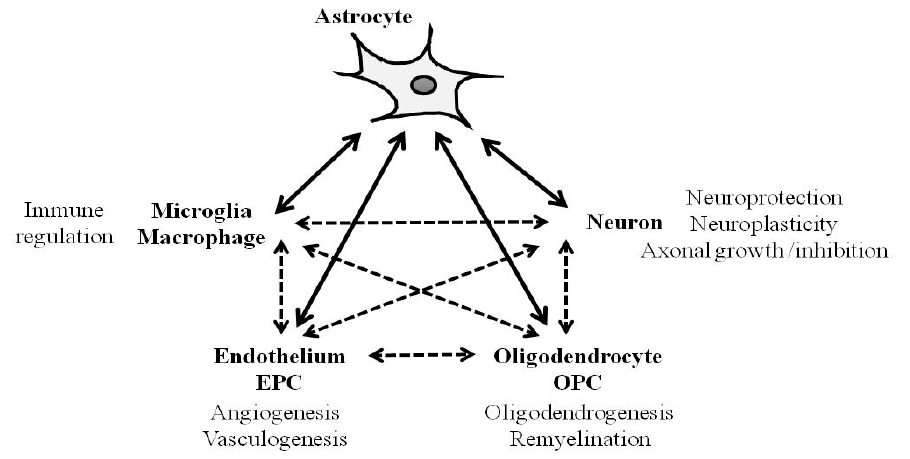
Figure 1. Schema of crosstalk between astrocytes and other cell type after CNS injury. After central nervous system (CNS) injury, reactive astrocytes are capable of communicating with each cell type including microglia, endothelial cells, endothelial progenitor cells (EPCs), and neurons, and this cell–cell interaction can regulate immune response, angiogenesis, vasculogenesis, oligodendrogenesis, neuroprotection, neuroplasticity, axonal growth or inhibition depending on the context. Bi-directional arrows show the mutual interaction. Broken arrows indicate other interactions that astrocytes are indirectly involved in.